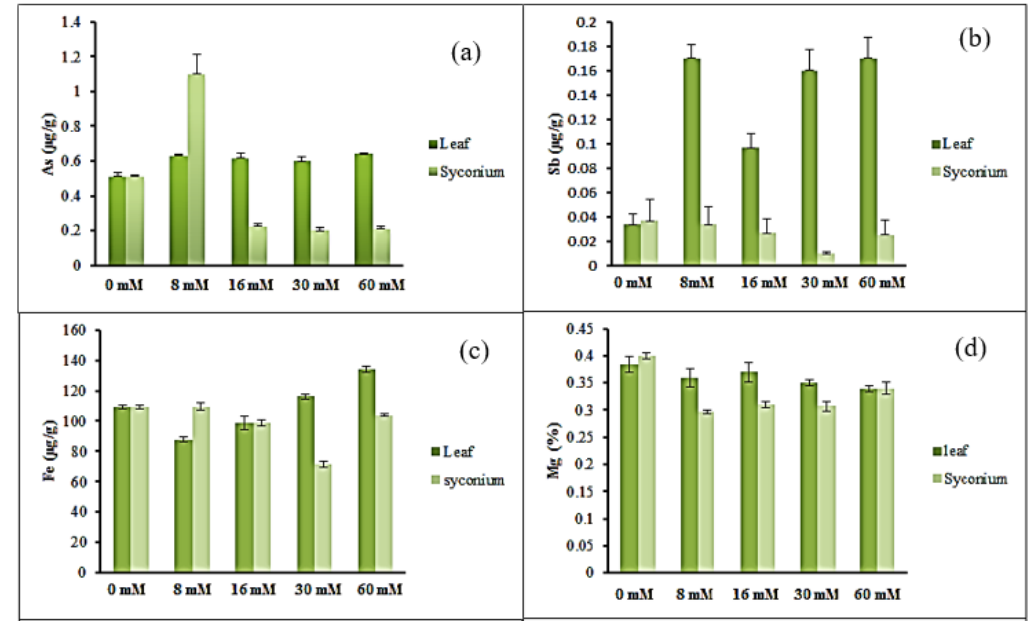
Figure 1. The effect of H 2 O 2 on (a) arsenic (As), (b) antimony (Sb), (c) iron (Fe), (d) magnesium (Mg) in leaf and syconium of Ficus deltoidea var deltoidea plant. Error bars indicate (± S. E).